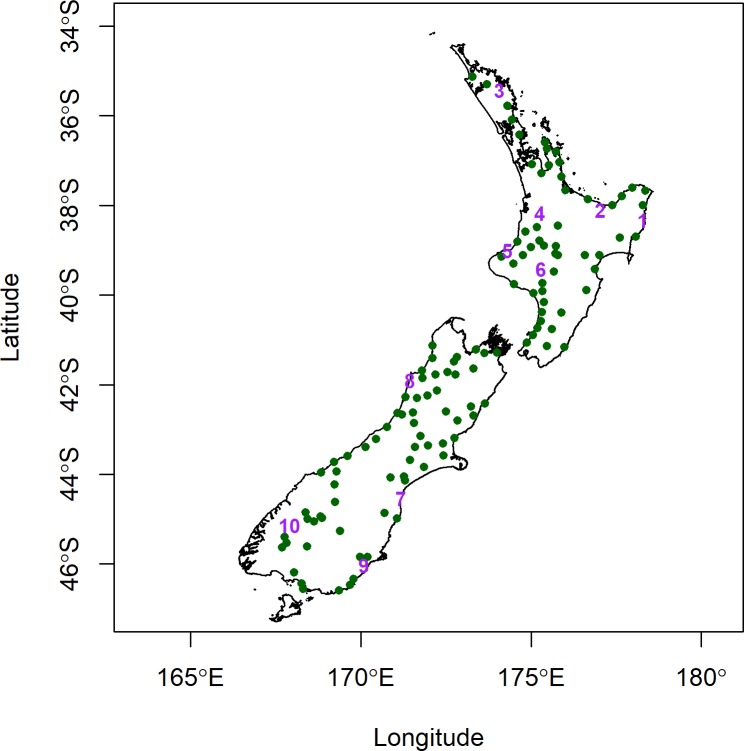
Map of the 130 sampled blackberry sites across New Zealand.The samples labelled 1–10 were further segregated as an external testing set for assignment.